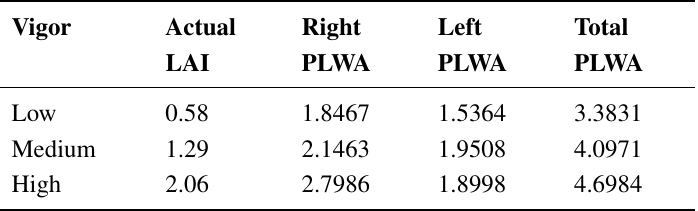
Table 1. Leaf area index (LAI) and pixelated leaf wall area